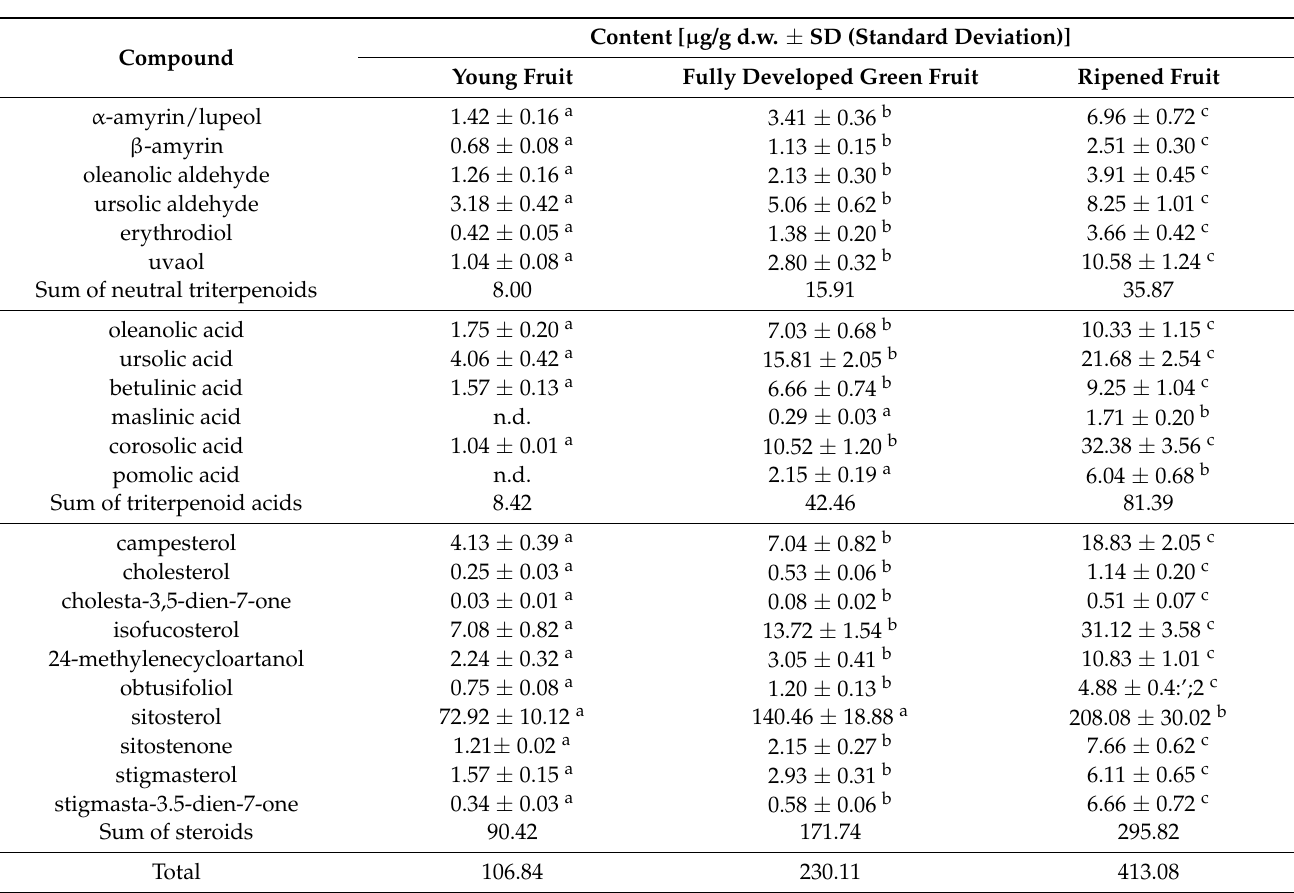
Table 2. Content of triterpenoids and steroids in achenes during rugosa rose ( Rosa rugosa ) fruit development.